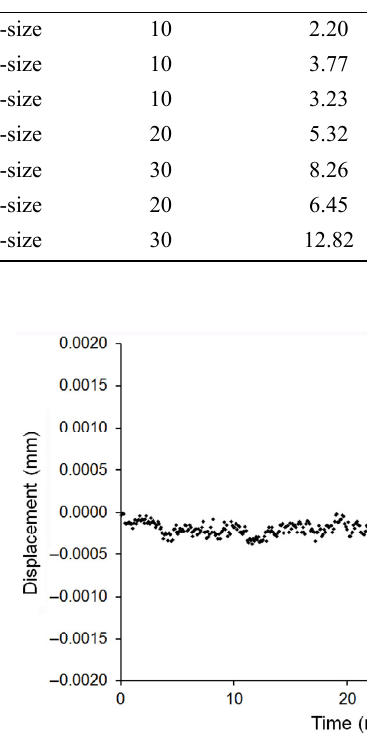
Fig. 7 Noise in the large-size apparatus. Force recorded from the load cell against time.